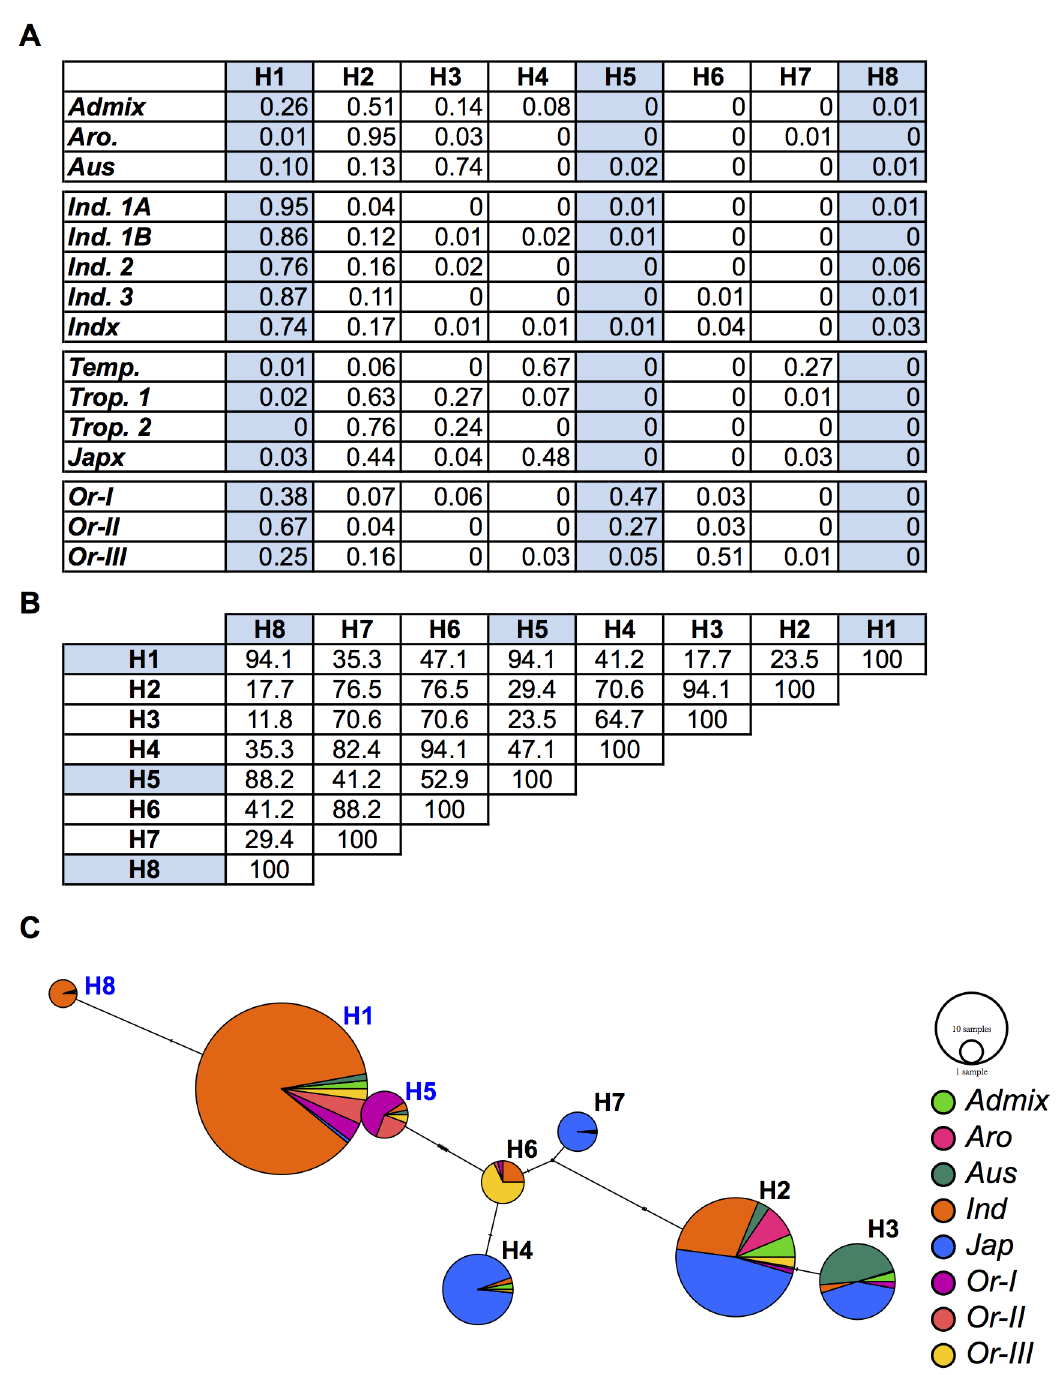
Fig 8. Haplotype analysis of a 37 kb region around HKT1;1 in cultivated and wild rice. (A) Haplotypefrequencies in a panel of 3,024 cultivatedrice accessions and 446 Oryza rufipogon accessions. (B) Pairwisecomparisons of sequence similarities in betweenthe haplotypes in A. High root Na + haplotypes (i.e. those with the three non-synonymous SNPs are highlightedin blue) (C) Haplotype network for the 37 kb regionsurrounding HKT1;1 . The size of each node is proportional to the number of accessions with the corresponding haplotype.Each node is separated into a pie chart, which indicatesthe numberof accessionsfor each population with the haplotype. Indica ( Ind ) accessionsare those belongingto Ind 1A , Ind 1B , Ind 2 , Ind 3 , and Indx . Japonica accessions are those belongingto Temp , Trop 1 , Trop 2 , and Japx .